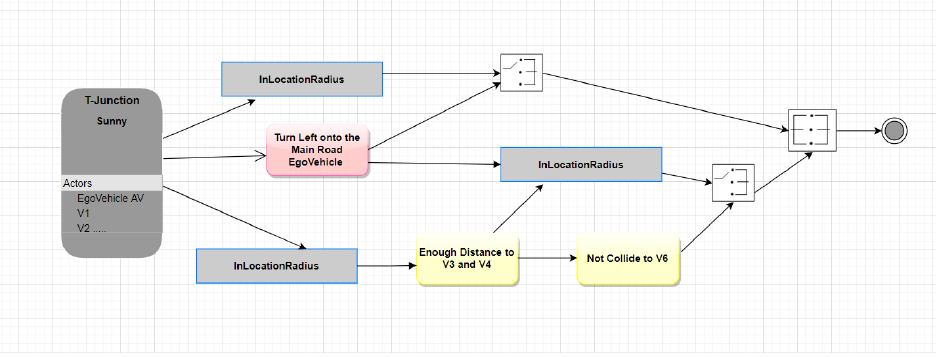
Figure 7. Turn left onto main road maneuver of example scenario using SceML